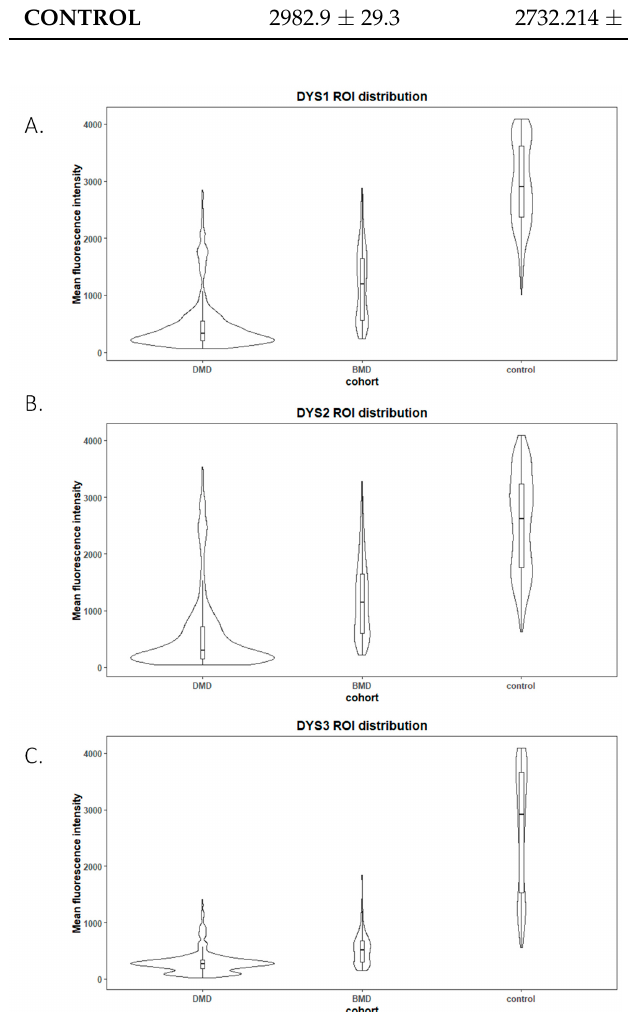
Figure 3. Violin plots of ROI fluorescent intensity distribution from each studied disease group ( n = 10 DMD, n = 3 BMD) and control ( n = 6) for the different antibodies used NCL-Dys1 ( A ), NCL-Dys2 ( B ) and NCL-Dys3 ( C ). These plots show that tested antibodies were suitable to separate patients according their diagnosis ( p -value < 0.05). NCL-Dys1 ( A ) was the antibody which showed